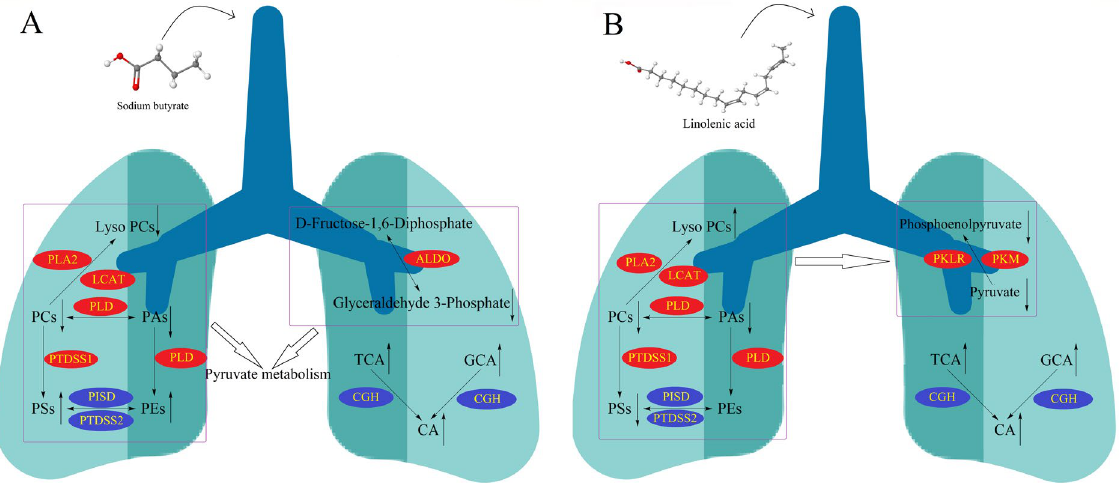
Figure 10. ( A ) Diagram showing sodium-butyrate-induced lung cancer molecular mechanism. ( B ) Diagram showing linolenic-acid-induced lung cancer molecular mechanism; Blue ellipse: down- regulated. Red ellipse: up-regulated.